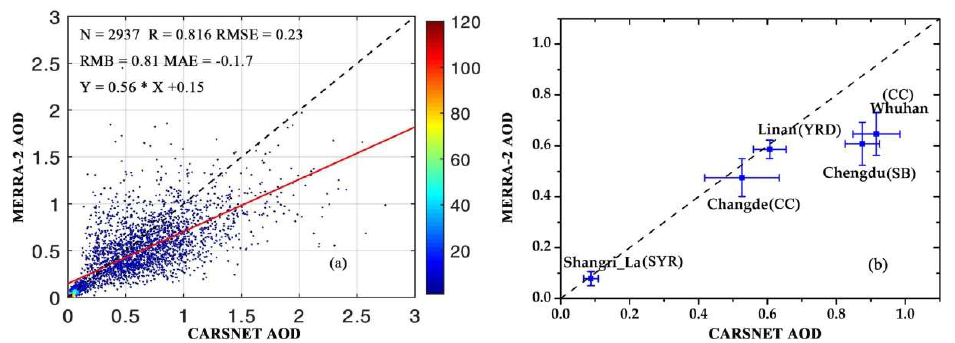
Figure 4. Scatter plot of daily averaged ( a ) and annual mean AOD ( b ) between MERRA-2 and CARSNET AOD at five ground sites of the YRB during 2013–2016. In ( b ), the vertical and horizontal bars refer to the standard deviations of the annual mean MERRA-2 and CARSNET AOD, respectively.